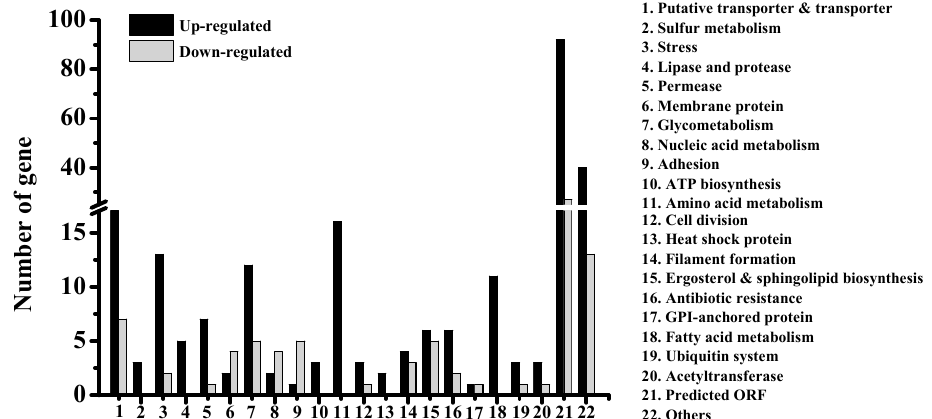
Figure 2. Functional classification of C. albicans genes regulated by BDSF (150 μ M) treatment.